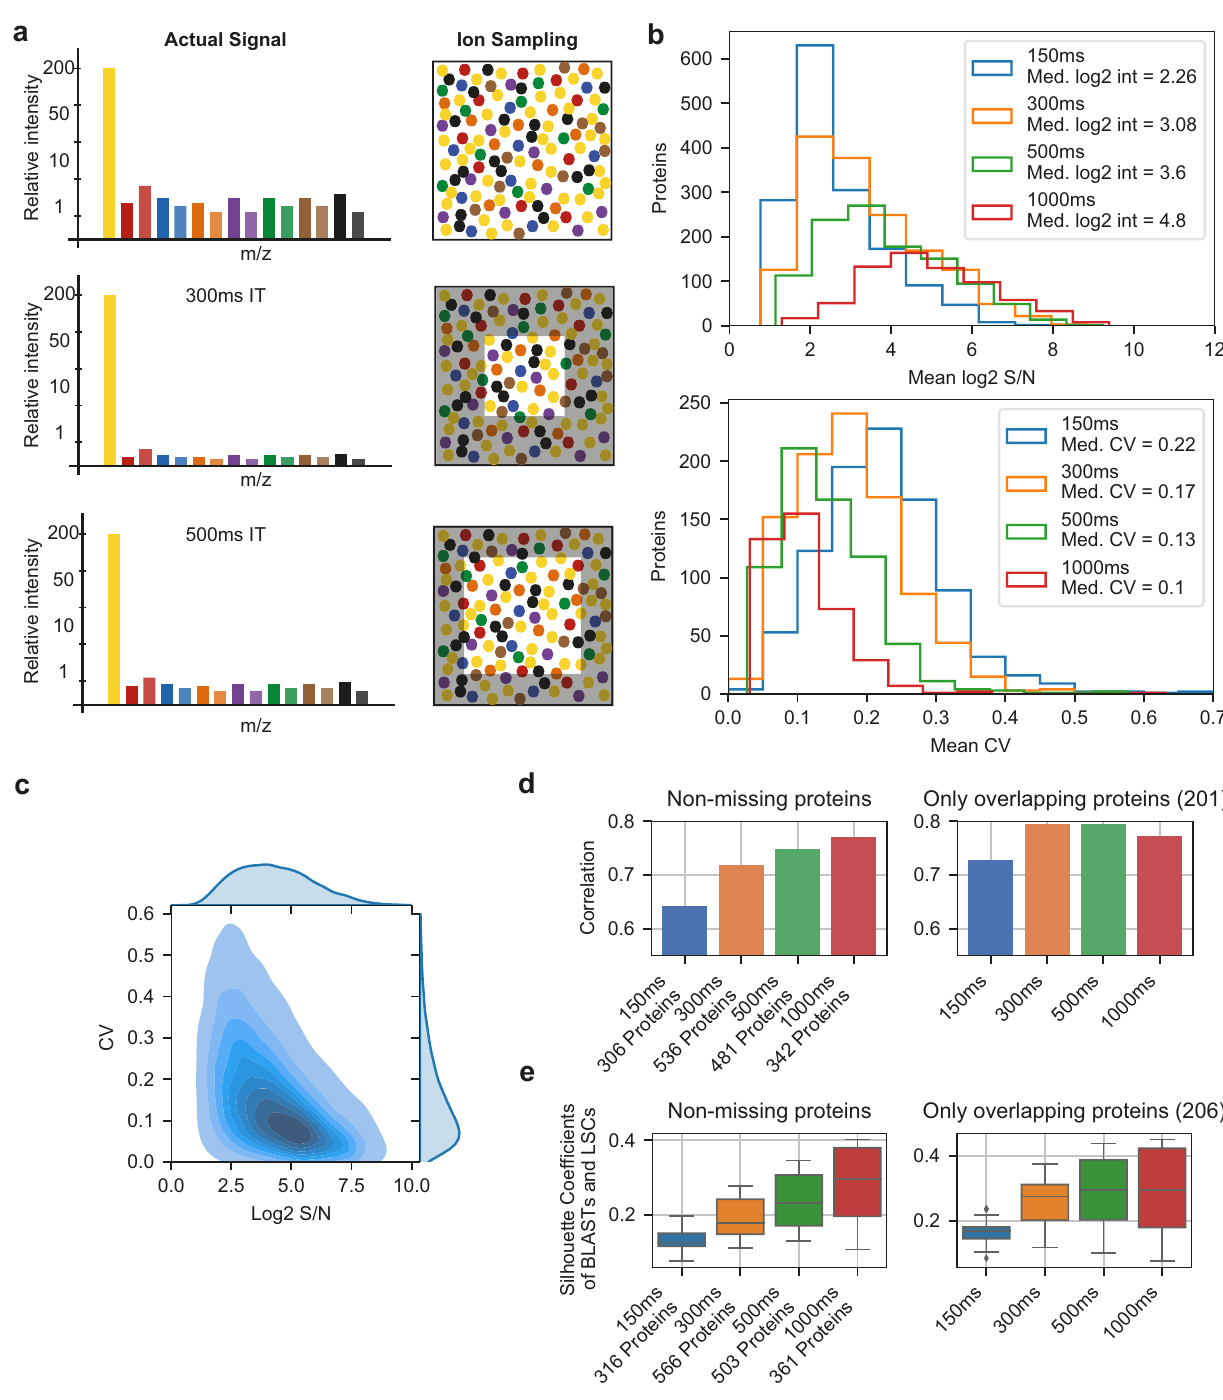
Fig. 2 Evaluating the quantitative accuracy of a booster-based scMS work fl ow. a Cartoon depicting the in fl uence of ion sampling (injection time, IT) on single-cell signal. b Evaluation of the effect of increased ion sampling. Top: Histograms of the mean log2 signal-to-noise (s/n) values of all single-cell channel measurements per protein for all four methods. Bottom: Histograms of the mean Coef fi cient of Variation (CV) per protein for all four methods. Up to 14 CVs per protein were calculated by normalizing the three replicates of each method by equalizing the median s/n of the single-cell channels for each protein across replicates and dividing the standard deviation of the normalized s/n of each protein in each single-cell channel across replicates by the mean of the raw s/n for each protein in each single-cell channel across replicates. The mean CV of up to 14 CVs per protein was reported, as CV calculation was only performed for n = 3. c Density plot of protein log2 s/n values and their CV from all four methods (i.e. up to 14 CVs per protein per method). d Pearson correlation coef fi cient of fold changes between LSC and blast in single-cell samples and MS3-level bulk data (n = number of proteins). Left: For each method, only proteins without missing values were considered (i.e. proteins quanti fi ed in all 14 channels in each replicate). Right: Only proteins overlapping between all methods in left were considered. Fold changes in single-cell samples were calculated from the means of all LSCs ( n = 15) and blast ( n = 12). e Silhouette coef fi cients of LSC ( n = 15) and blast ( n = 12) for each method, calculated in PCA space using the same protein selection as in panel d. Boxplot shows median, 0.25 and 0.75 quantile, and whiskers extend to points within 1.5 interquartile range of lower and upper quartile. Source data are provided as a Source Data fi